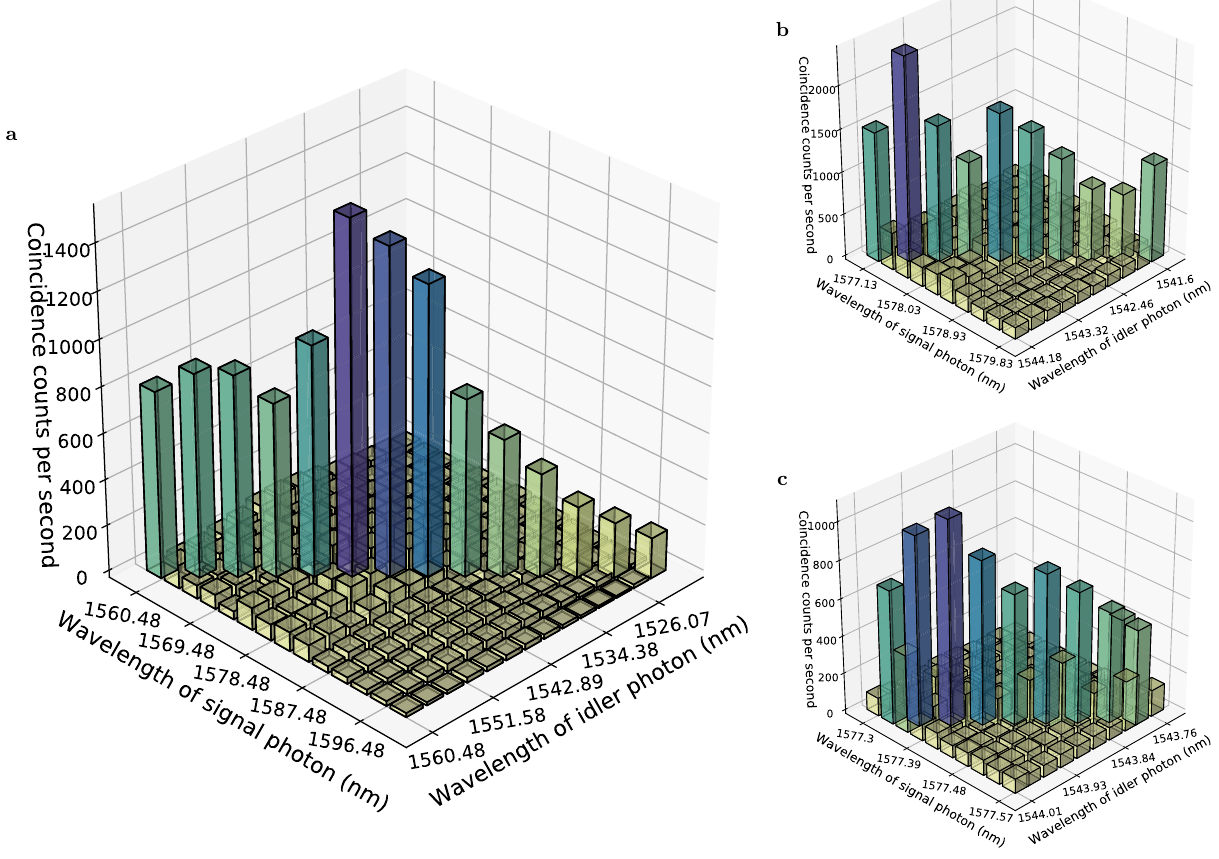
Figure 2. Joint spectral intensity. Coincidence counts among frequency modes with spectral resolutions of ( a ) 3.00 nm, ( b ) 0.30 nm, and ( c ) 0.03 nm are shown. The resolutions are selected using the BPFs. The pump powers are adjusted based on the resolution to 50 μW, 500 μW, and 5 mW for ( a – c ), respectively. Peaks appear at the specific frequency combinations that satisfy the energy conservation with the pump, signal, and idler photons in all frequency ranges measured: ( a ) [1560.48 nm, 1599.48 nm] and [1522.43 nm, 1560.48 nm], ( b ) [1577.13 nm, 1579.83 nm] and [1541.60 nm, 1544.18 nm], and ( c ) [1577.30 nm, 1577.57 nm] and [1543.76 nm, 1544.01 nm]. The range of ( b ) is equivalent to the spectral resolution of ( a ) and the range of ( c ) is the spectral resolution of ( b